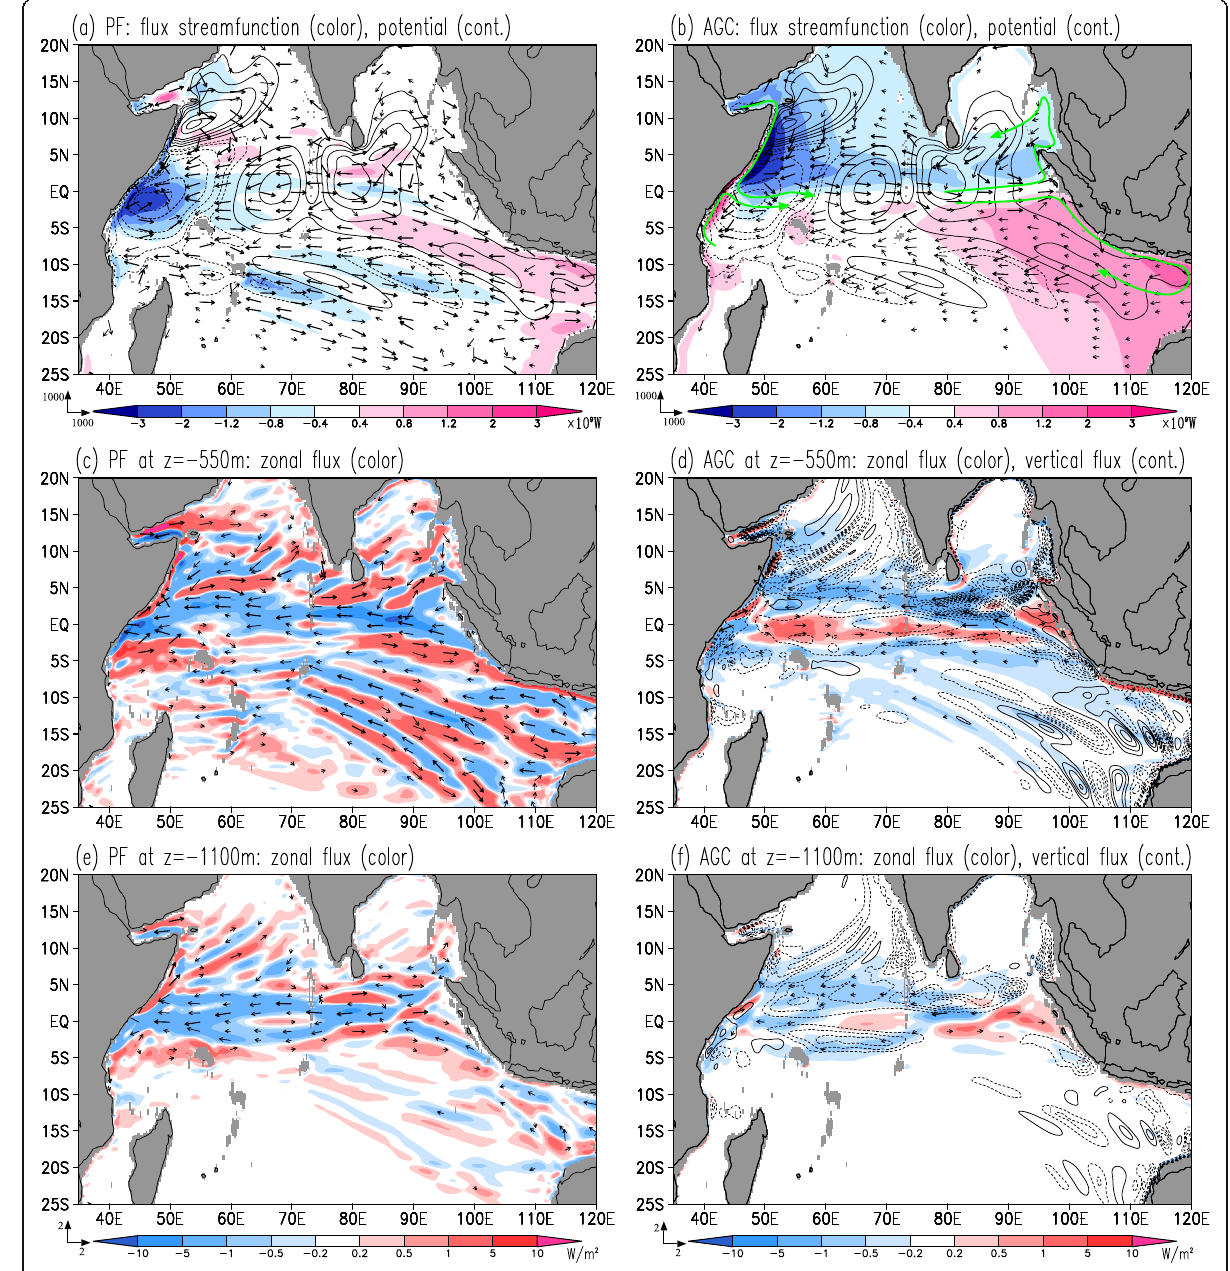
Fig. 4 a , b Depth-integrated energy flux streamfunctions (color shaded in units of 10 9 W = GW), depth-integrated energy flux potentials (solid contours for positive values and dotted contours for negative values; contour interval = 0.05 GW), and depth-integrated energy flux vectors (arrows in units of W/m). c , d The zonal component of the energy flux (color shaded in units of W/m 2 ) and the energy flux vector (arrows in units of W/m 2 ) at 550 m depth. e , f Same as c and d except that depth is now 1100 m. All quantities represent annual mean values taken from “ Year 20 ” of the model experiments, and estimated by the pressure flux scheme (left panels) and the depth-dependent version of the Aiki, Greatbatch, and Claus Level-2 scheme (right panels). Panel ( b ) includes two groups of cyclonic circulations of wave energy shown by green arrows that are demonstrated in LA20. Panels ( d and f ) include the vertical component of the energy flux, shown by contours (solid for positive and dotted for negative values) at an interval of 10 − 4 W/m 2 . When under 1000 W/m, the magnitude of the depth-integrated energy flux vectors in ( a , b ) is indicated either by arrow length or, for greater values, by heavy arrows of uniform length. Arrows in the series c , d , e , and f are displayed in a similar fashion to ( a ) and ( b ), with the magnitude of the energy flux indicated either by arrow length (when under 2 W/m 2 ) or by heavy arrows of uniform length for greater